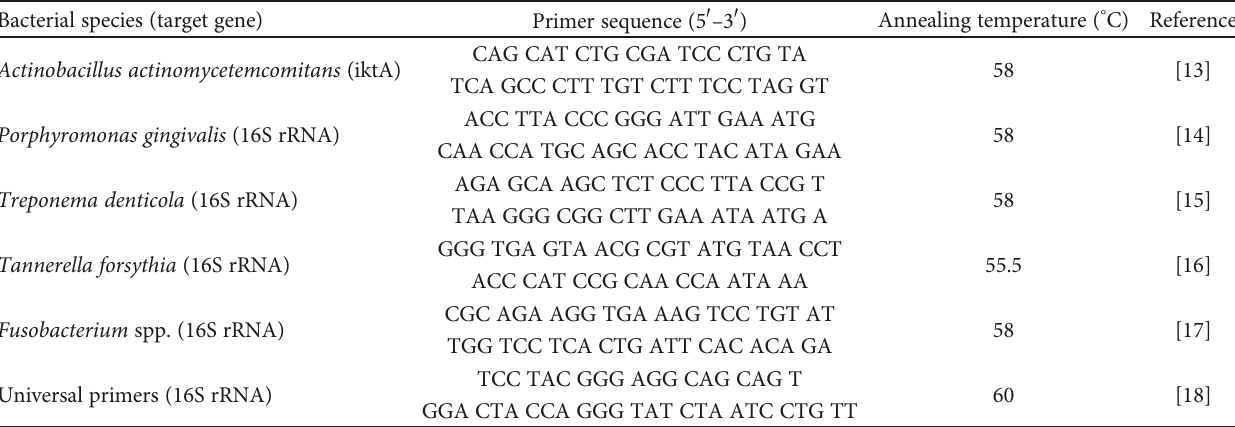
Table 1: List of the primers used in real-time PCR experiments with the annealing temperatures for each assay. Bacterial species (target gene) Primer sequence (5 ′ – 3 ′